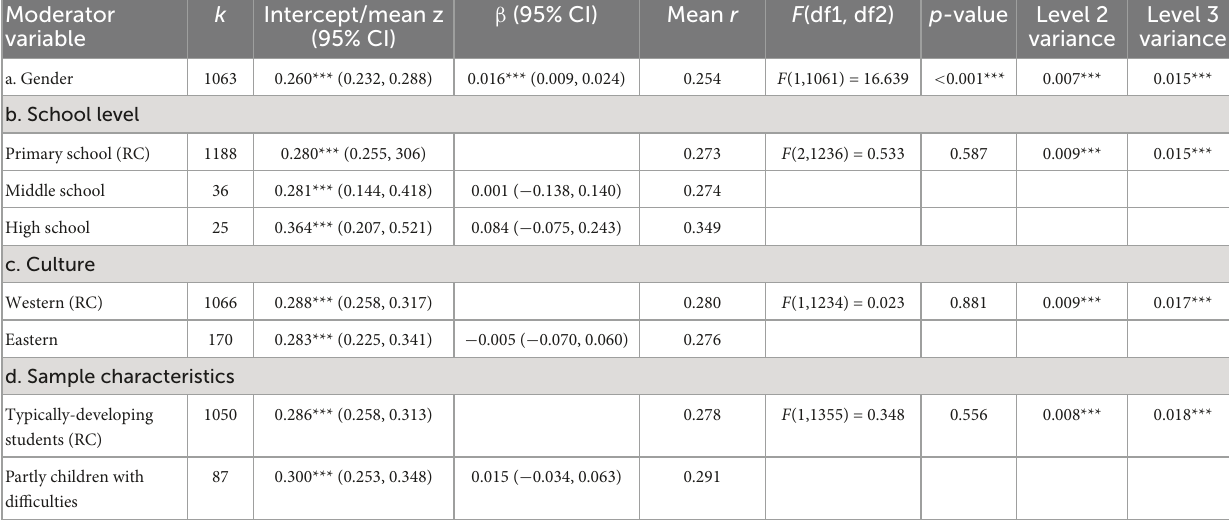
TABLE 2 Relation between working memory (WM) and participant